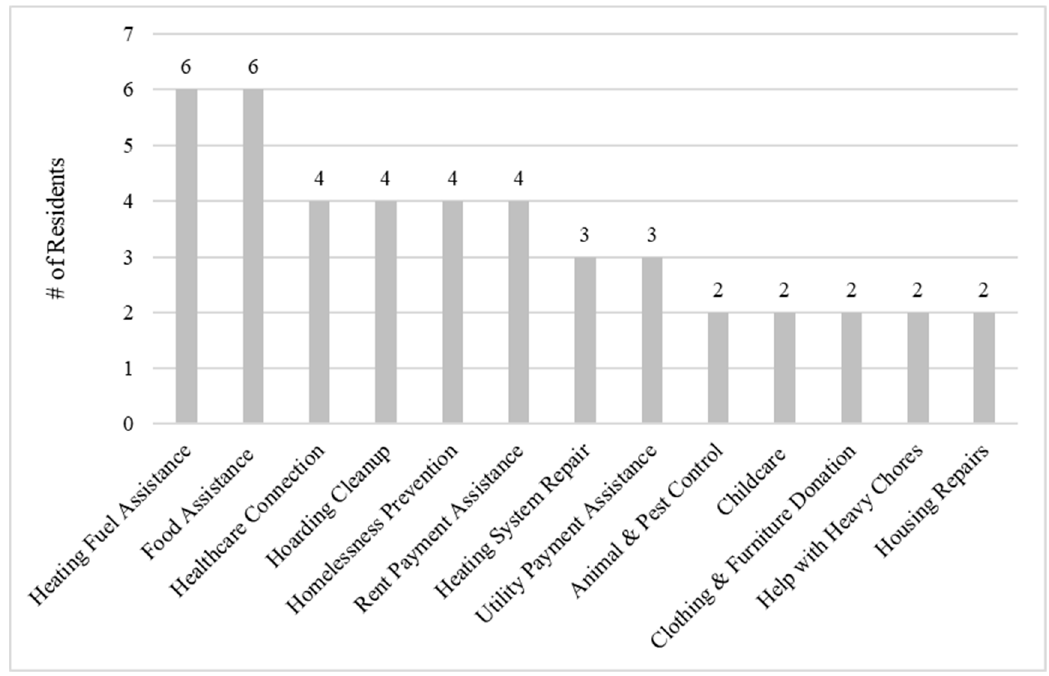
Figure 1. Social services delivered to residents referred by housing inspectors through the Social Service Referral Program.